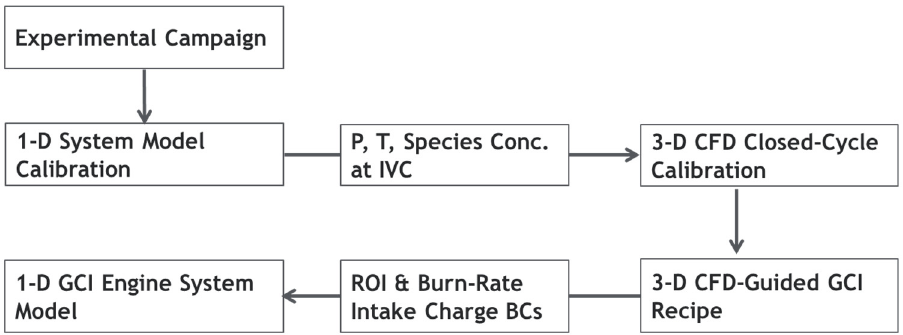
Figure 5. A flowchart of the 1-D and 3-D model close-coupling